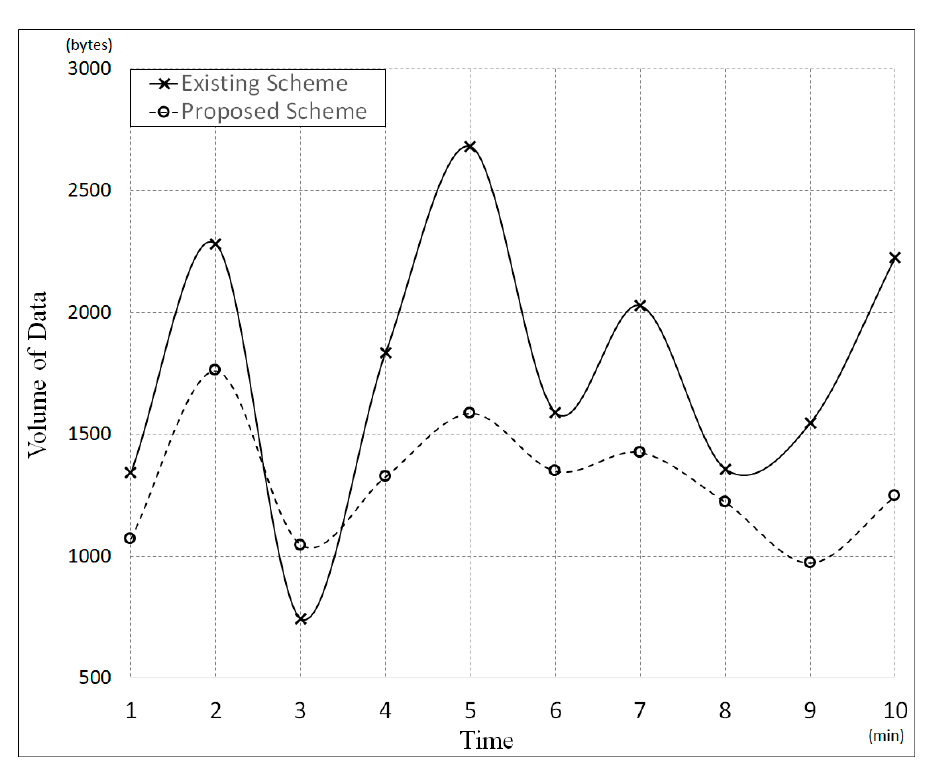
Figure 21. Comparison of bandwidth usage during experimentation. Table 4. Comparison of bandwidth usages for candidate schemes.